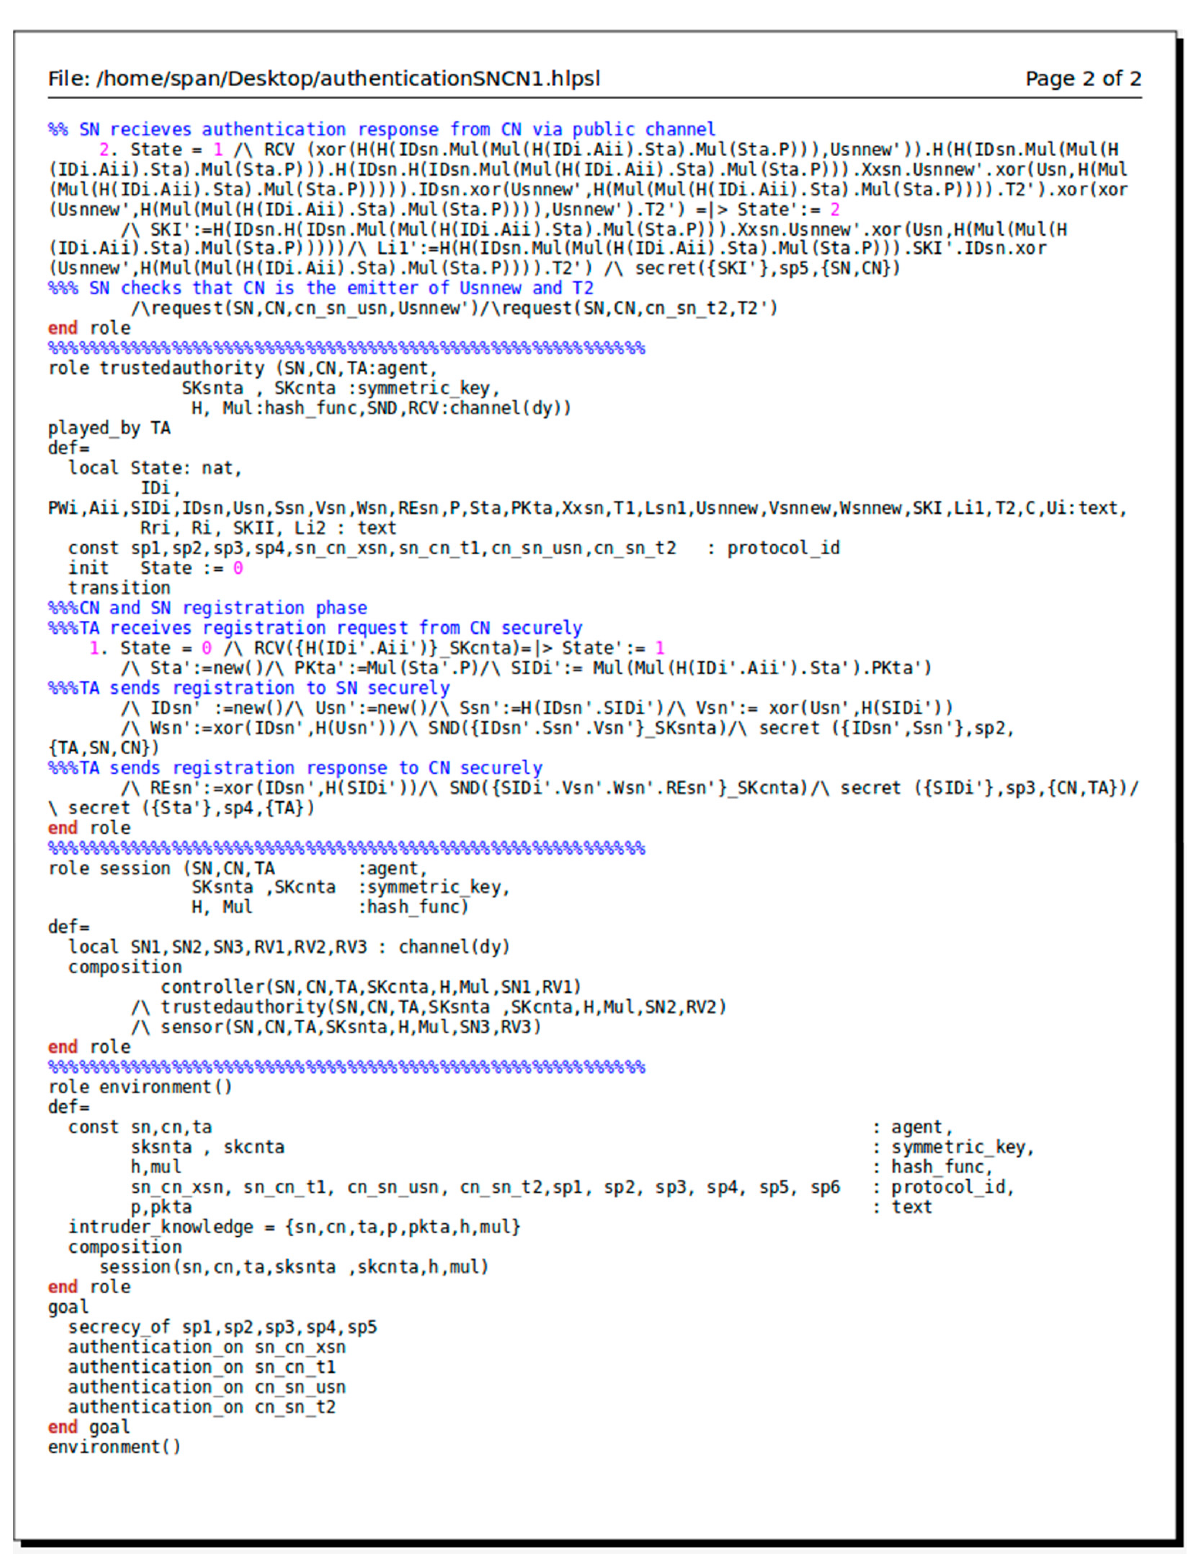
Figure 7. HLPSL code for protocol-I.